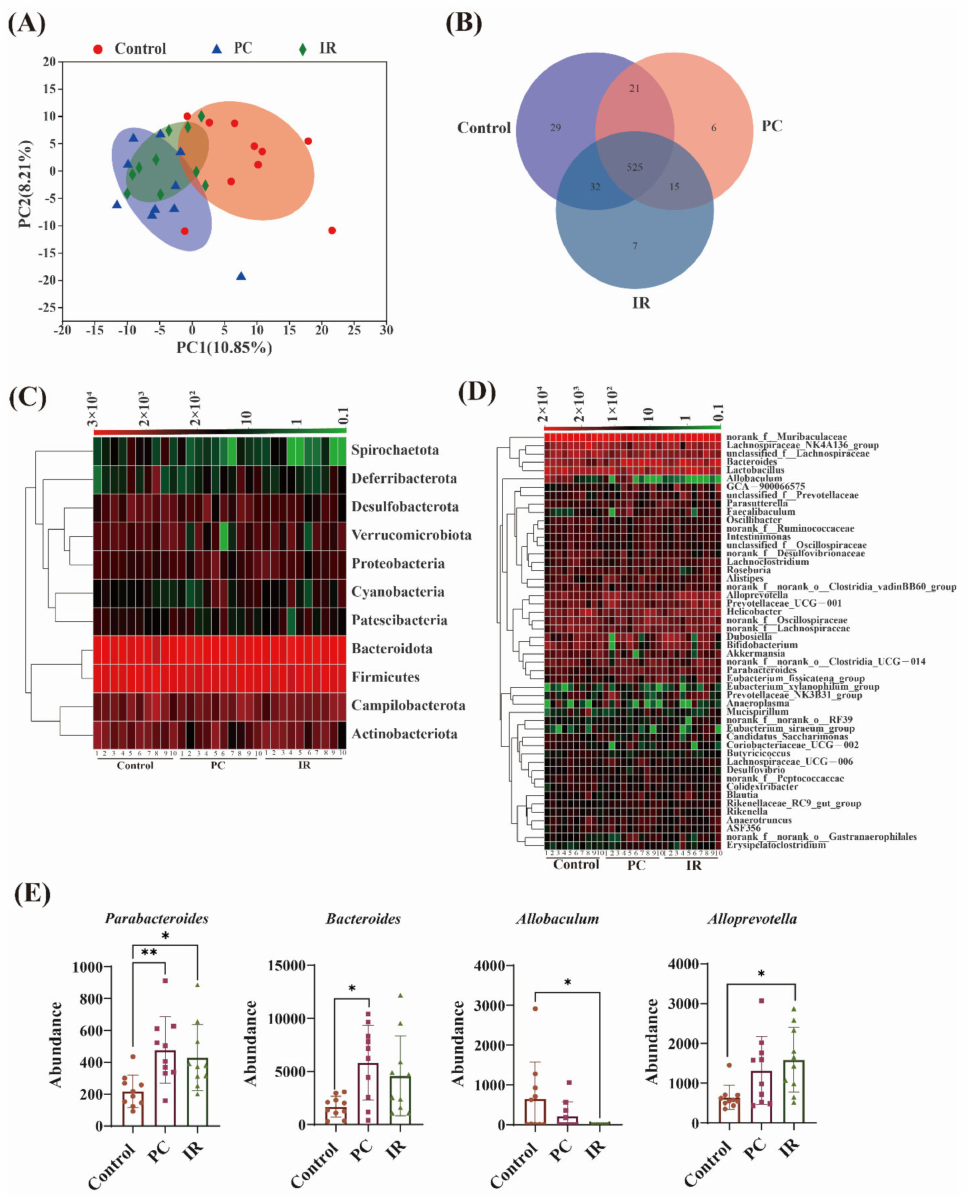
Figure 2. PC and IR alter the composition of gut microbiota in mice. ( A ) PCA clustering analysis. ( B ) Venn diagrams showing the unique and shared OTUs in the gut microbiota among groups. ( C ) Heatmap indicating the relative contribution of the top 11 dominant phylum and ( D ) top 50 dom- inant genera in each group. ( E ) The gut microbiota with significant differences in abundance among groups. One-way ANOVA was used to analyze statistical differences, * p < 0.05, ** p <